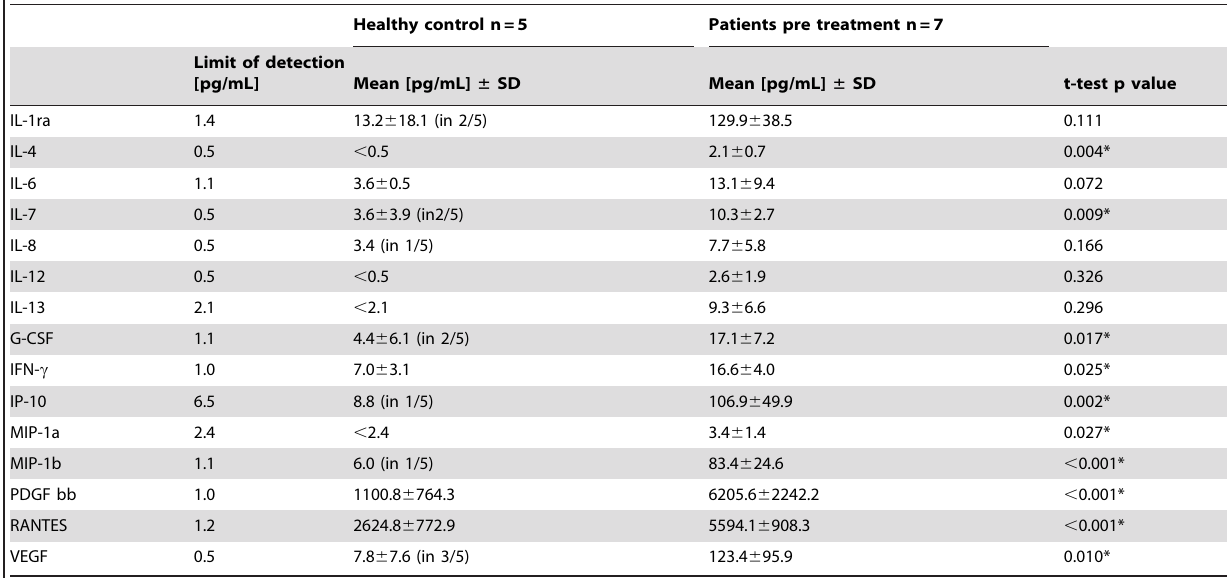
Healthy control